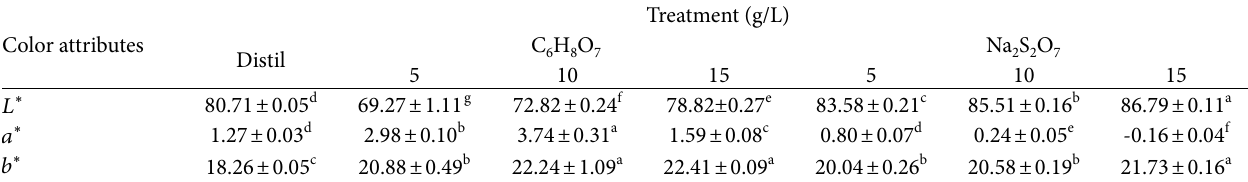
Results are means ± standard deviation ( 𝑛 = 3 ). Values across rows followed by different letters are significantly different ( 𝑝 < 0.05 ). Distil: distill water